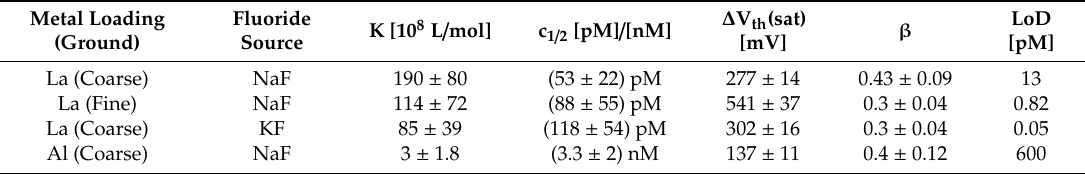
Table 1. Parameters of Langmuir–Freundlich fits to fluoride response. K, c 1 / 2 , ∆ V th (sat), β , and limit of detection (LoD) for the response of WGTFTs sensitised with La-and Al-loaded chelating resins to fluoride. We only used coarse-ground resin-filled membranes. The results for fine-ground La-loaded resin from Figure 5 in Section 3.2 below are previewed here but discussed only